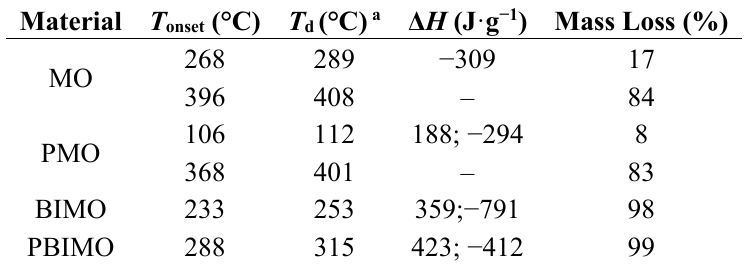
Table 1. T onset , T d , Δ H and mass loss of MO, PMO, BIMO and PBIMO.